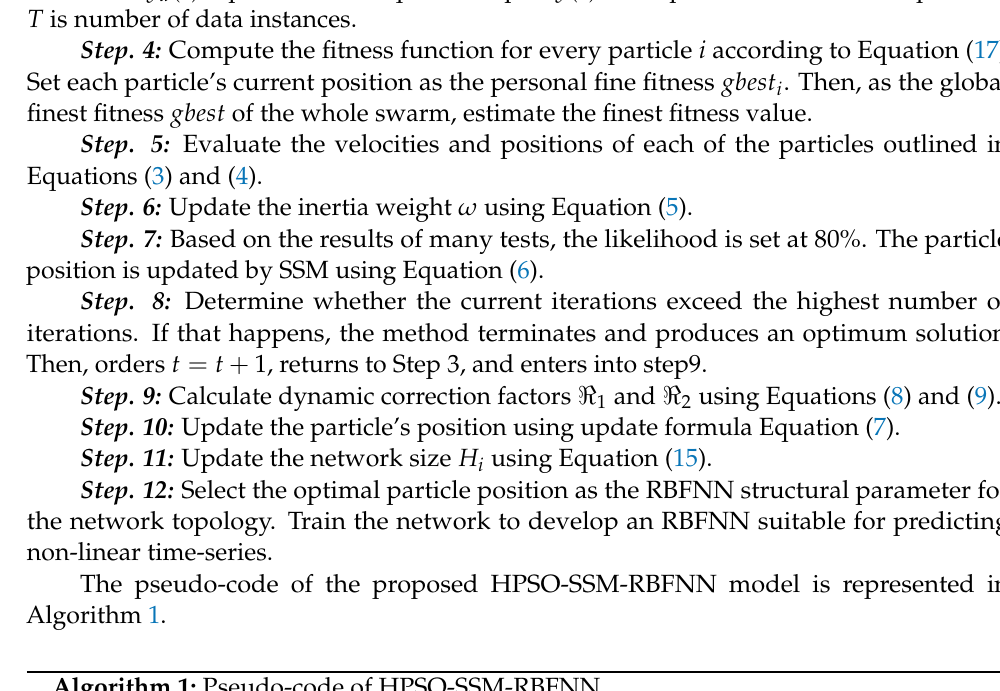
Algorithm 1: Pseudo-code of